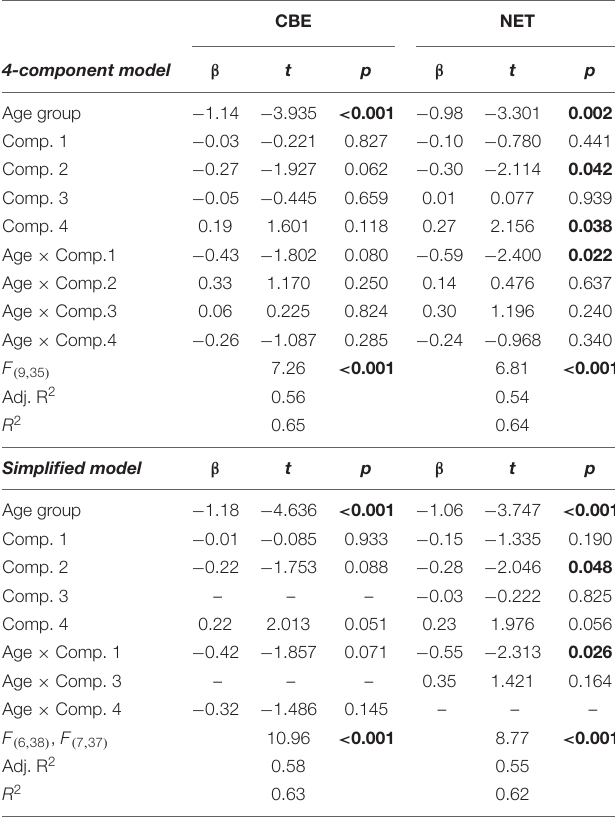
TABLE 3 | Multiple regression analyses investigating the possible links between the EEG components extracted using PCA and allocentric spatial working memory performance (CBE,